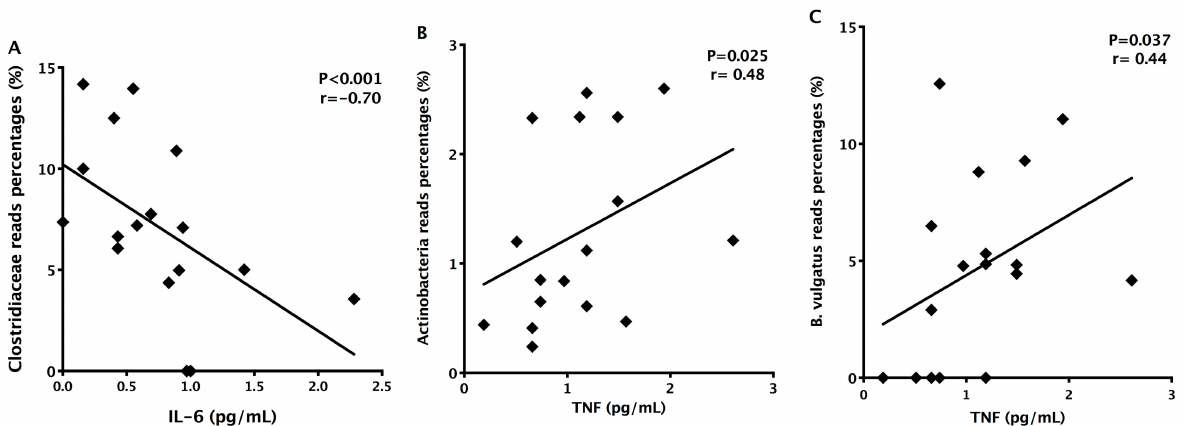
Figure 5. Correlations among relative abundances of bacterial taxa and serum concentrations of inflammatory cytokines. ( A ) Negative correlation between relative abundance of Clostridiaceae and IL-6 concentrations in RRMS patients; ( B ) Positive correlation between relative abundance of Actinobacteria and TNF concentrations; ( C ) Positive correlation between Bacteroides vulgatus and TNF concentrations. Statistical analyses were performed by Spearman’s test. Significance was set at p <